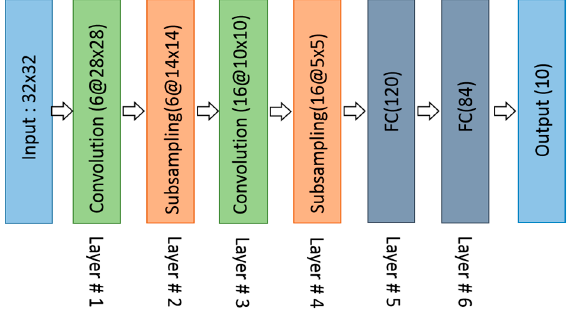
Figure 11. The architecture of LeNet.